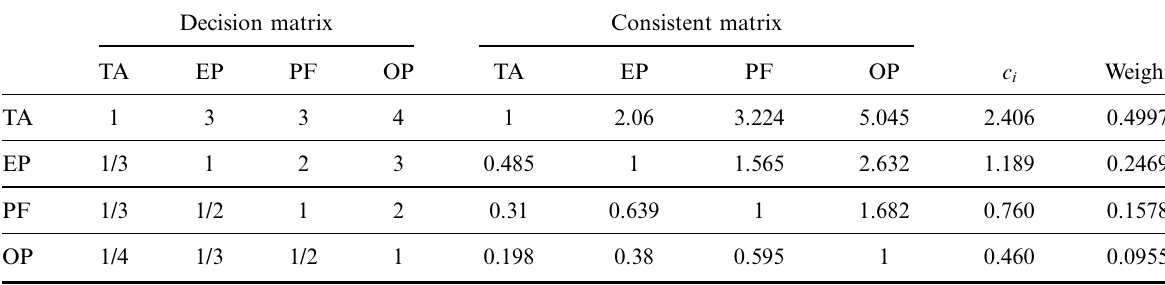
Table 2. Decision matrix, consistent matrix and weights of objectives Decision matrix